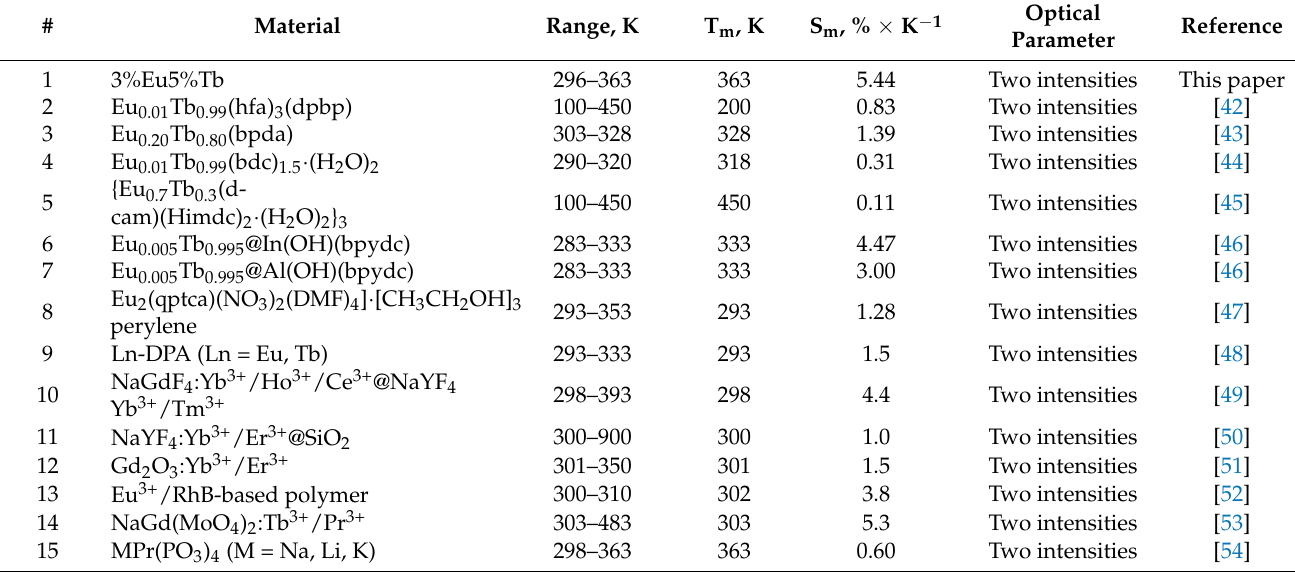
Table 1. Comparative temperature relative sensitivity of various Ln 3+ -based luminescent thermometers.